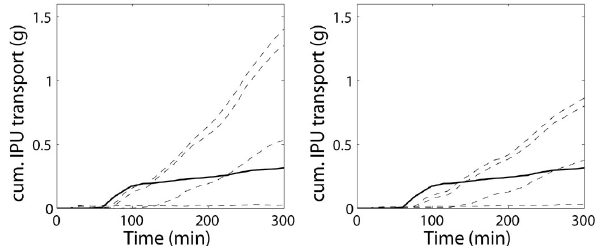
Fig. 9. Modelling IPU transport with spatial homogenous (left) and spatial heterogeneous (right) sorption parameter. The solid black line denotes the sampled cumulative breakthrough curve, the dashed lines display the modelled breakthrough